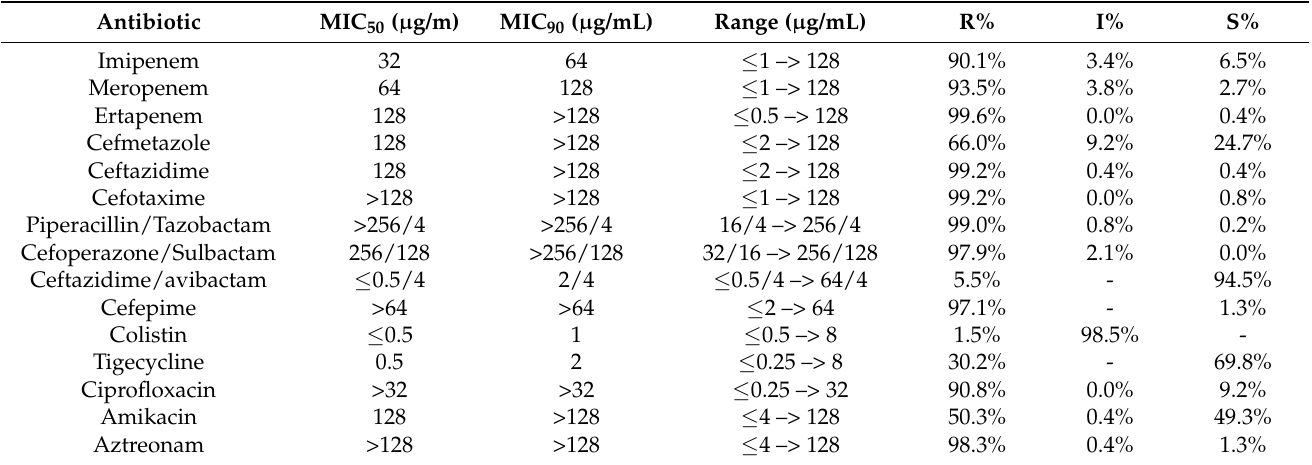
Figure 1. The distribution of carbapenemases, MLST and MIC values of CAV among 477 CRKP strains. ( a ) The distribution of carbapenemases. ( b ) The distribution of MLST. ( c ) The comparison of MIC values of CAV in 477 CRKP strains collected during 2018–2021. Table 1. Susceptibility of 477 CRKP strains to commonly used antibiotics.